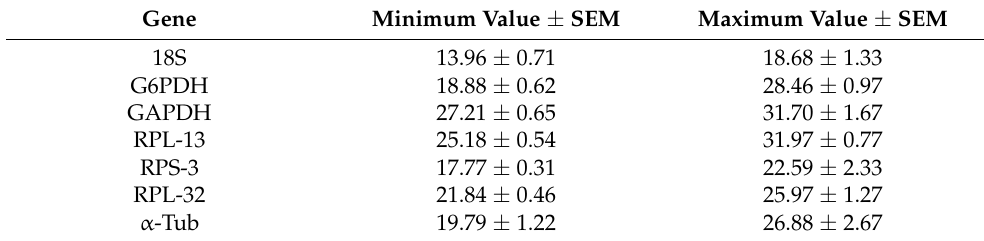
Figure 2. Ct values for all candidate reference genes in B. dorsalis under various phytosanitary treatment conditions. The x axis is gene, y axis is the Ct value, “ ” is a mild outlier, and “*” is an (cid:35) extreme outlier. The two horizontal lines above and below each box represent the maximum and minimum values of Ct, the middle horizontal line represents the median, and the upper and lower horizontal lines of the box represent the upper and lower quartiles, respectively. Table 4. The Ct (Cycle threshold) values of the seven